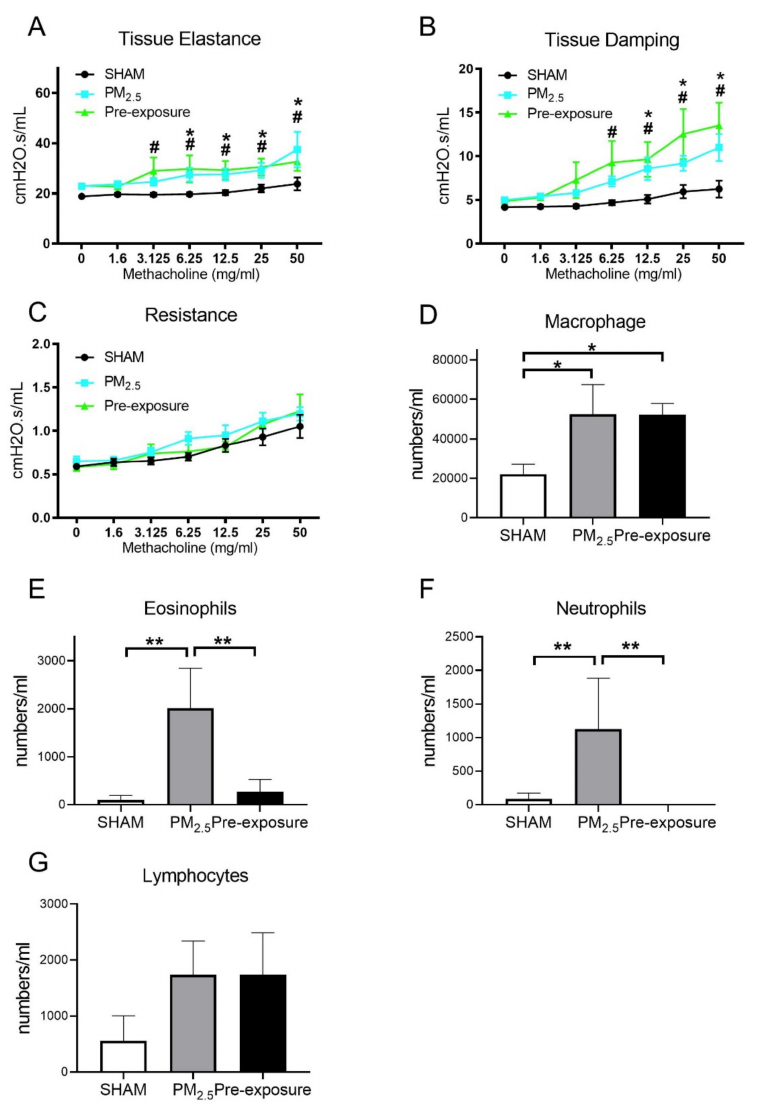
Figure 7. Lung function and leukocytes numbers in the female offspring at 13 weeks. Lung function of ( A ) tissue elastance, ( B ) tissue damping, ( C ) resistance, and the number of ( D ) macrophages, ( E ) eosinophils, neutrophils ( F ) and lymphocytes ( G ) in the dams. Results are expressed as means ± SEM. Data were analysed by one-way ANOVA followed by Fisher’s LSD post hoc tests, lung function was analysed by the Two-stage linear step-up procedure of Benjamini, Krieger, and Yekutieli followed by controlling the False Discovery Rate. n = 8. In (A,B) * p < 0.05, ** p < 0.01, SHAM vs. PM 2.5 . # p < 0.05, SHAM vs. Pre-exposure. In ( D – F ) * p < 0.05, ** p < 0.01. PM 2.5 : dams exposed to PM 2.5 (5 µ g/day) prior to mating for 6 weeks during gestation and lactation. Pre-exposure: dams exposed to PM 2.5 for 6 weeks prior to